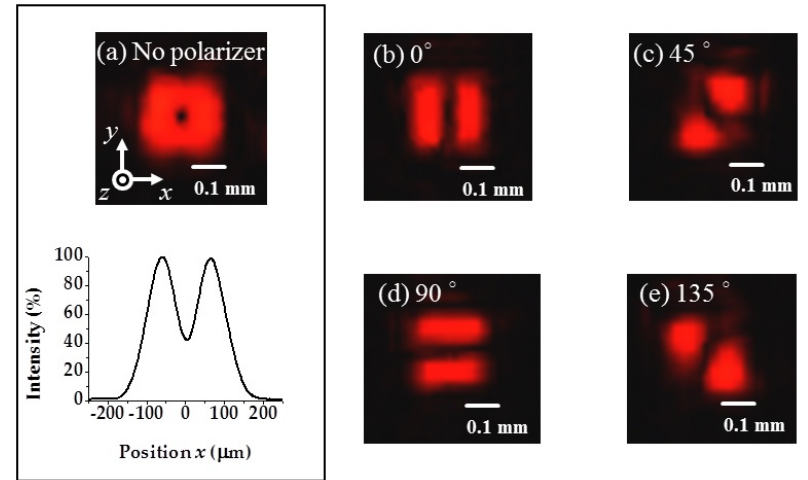
Figure 2. Radially polarized lights in the transmission output converted from a linearly polarized light: ( a ) donut ‐ shaped beam profile and intensity distribution in the x ‐ direction observed without an analyzer, and beam profiles observed with the transmitting axis of an analyzer at ( b ) 0°; ( c ) 45°; ( d ) 90°; and ( e ) 135° with respect to the x ‐ axis.